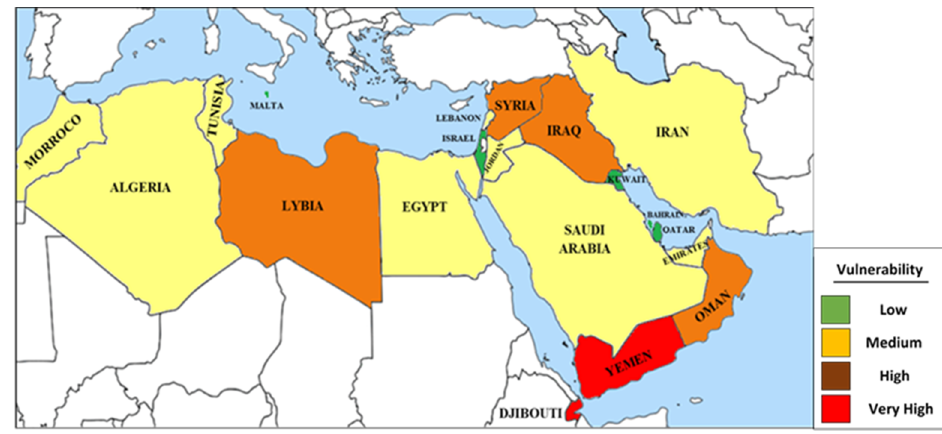
Figure 3. MENA vulnerability map.